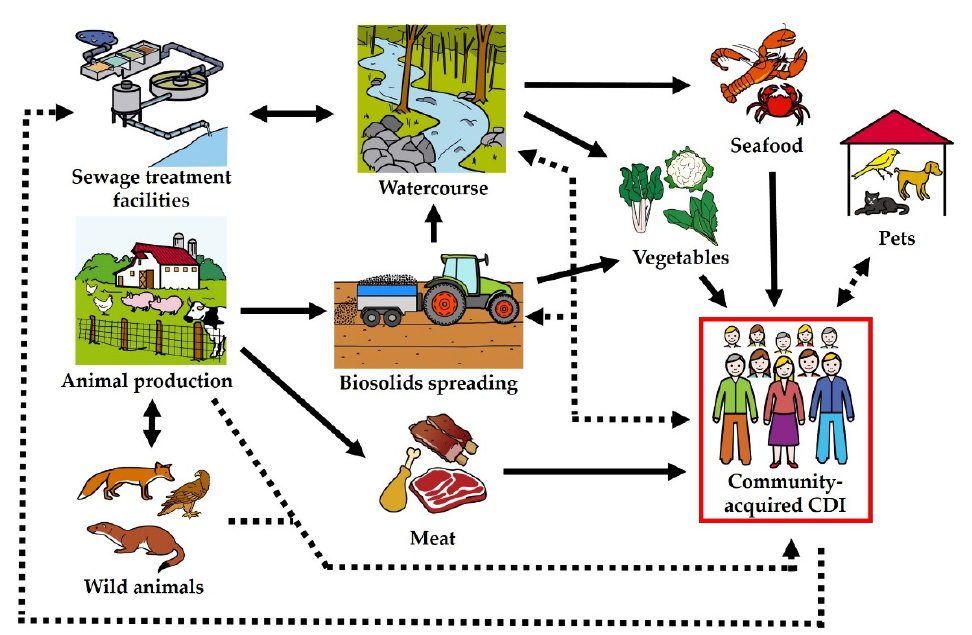
Figure 4. The cycle of community-associated CDI infections from zoonotic, environmental or food- borne sources. Adapted from [100] using ARASAAC pictograms.